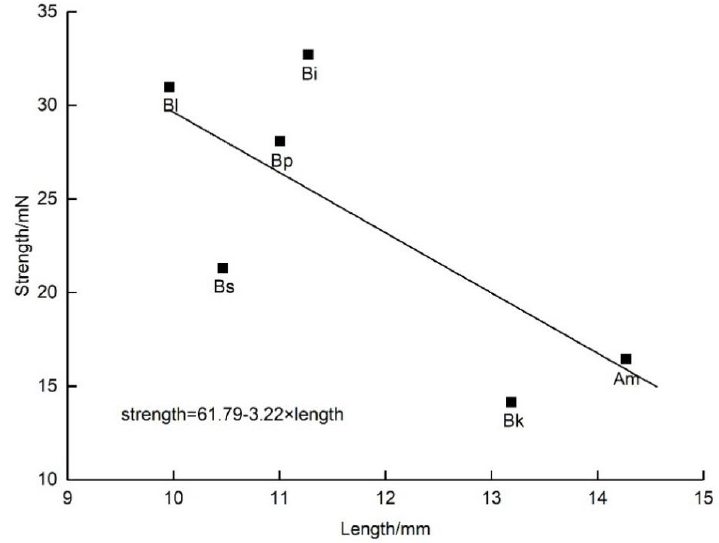
Figure 7. Linear regression with visitors’ length as an independent variable and strength as a de- pendent variable. p = 0.016; r 2 = 0.651. Am, A. mellifera . Bi, B. impetuosus . Bk, B. kashmirensis . Bl, B. lepidus . Bp, B. pyrosoma . Bs, B. sichelii . B. lepidus . Bp, B. pyrosoma . Bs, B. sichelii .